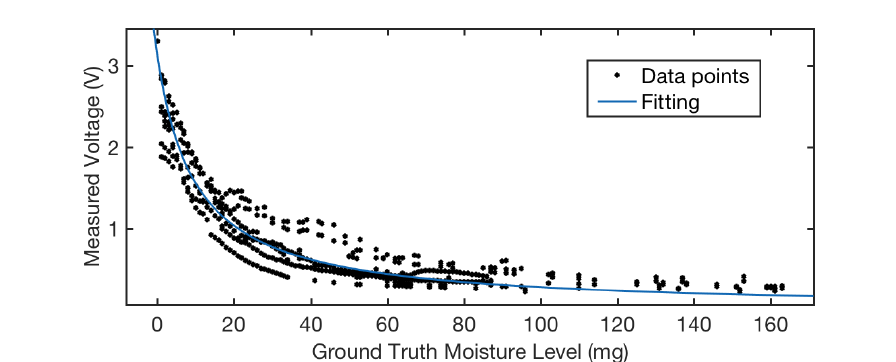
Figure 7. Sensor characterization: thread resistance vs. solution quantity